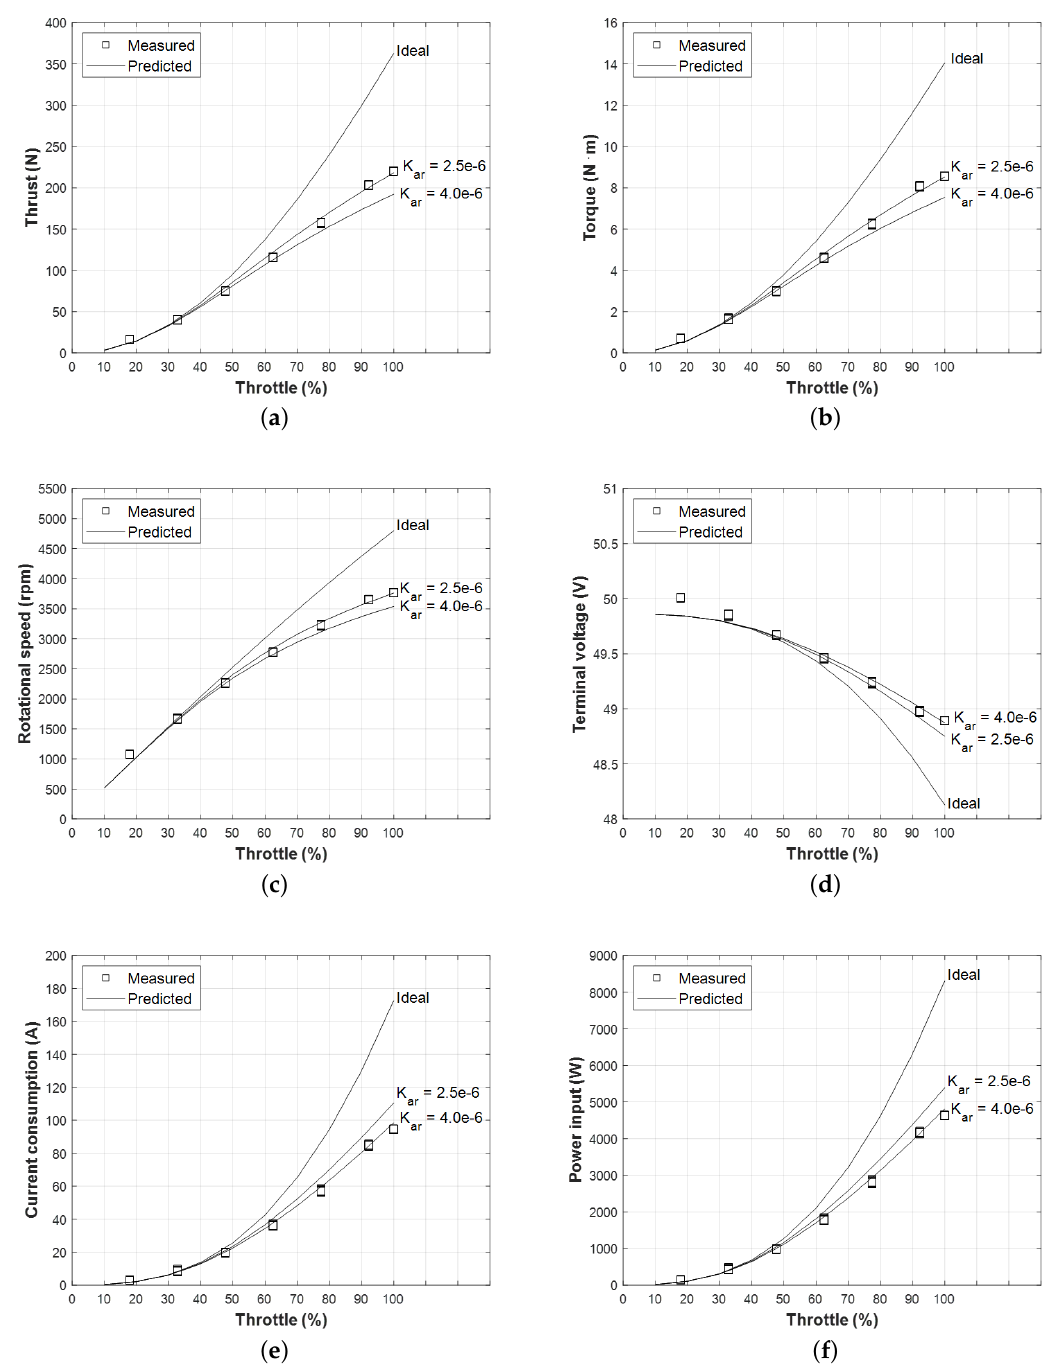
Figure 25. Performance prediction results of sample set 2 (KDE13218XF-105 with KDE-CF-355-DP) compared with static thrust test results: ( a ) Thrust, ( b ) torque, ( c ) rotational speed, ( d ) terminal voltage, ( e ) current consumption, and ( f ) power